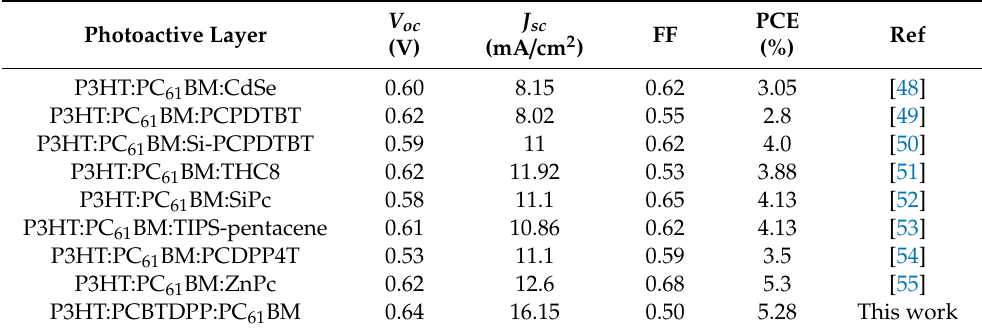
Table 3. Summary of the PV performances of recent ternary polymer solar cells